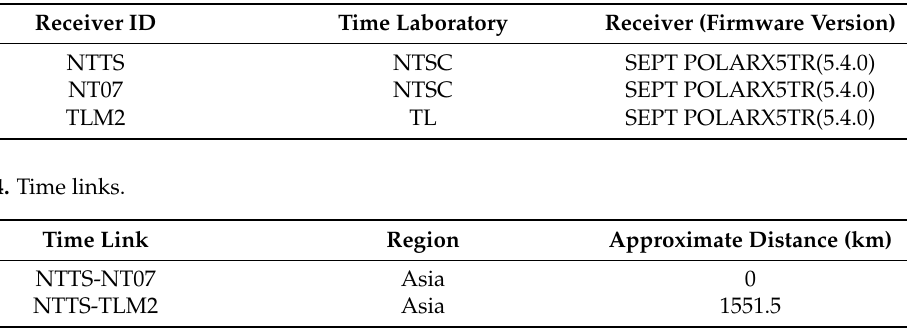
Table 3. Receiver information.